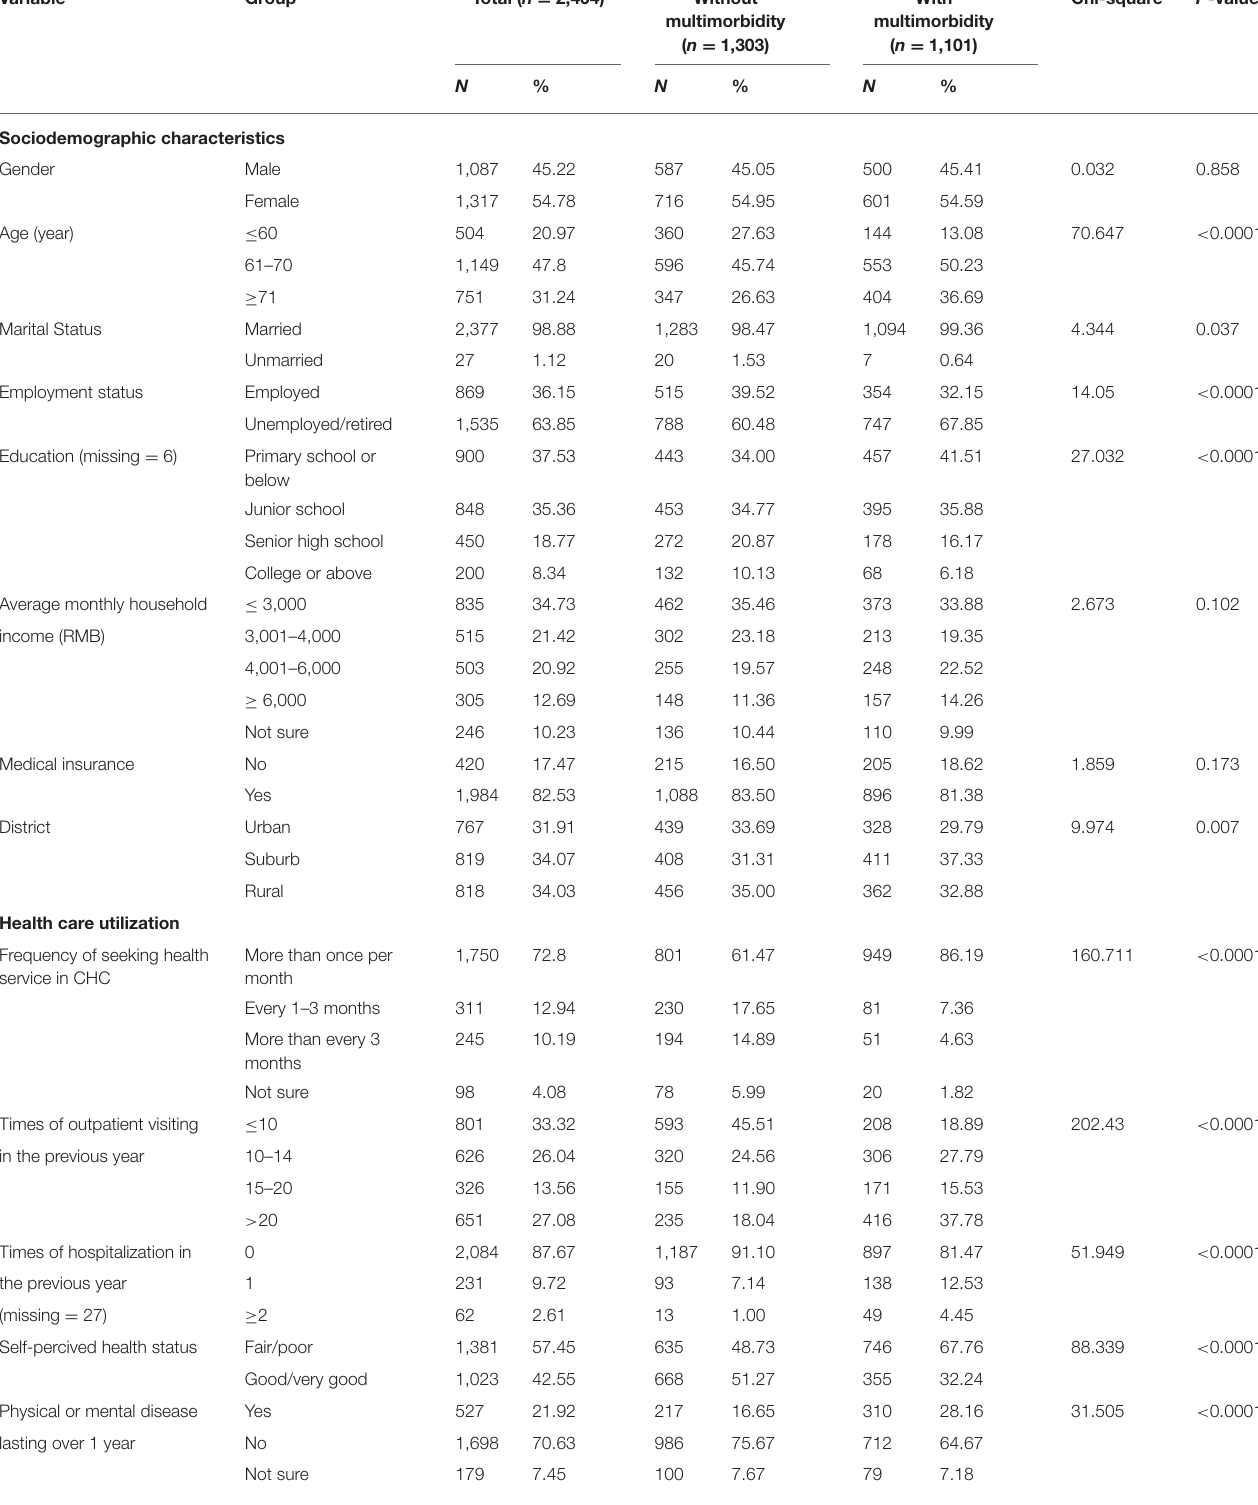
TABLE 1 | Participant characteristics in the study ( N = 2,404).